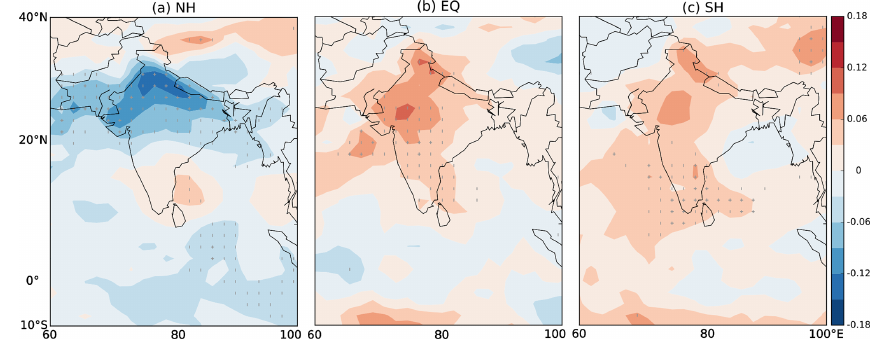
Figure 10. Spatial distribution of JJA mean total cloud cover (%) anomaly after the NH (a) , EQ (b) and SH (c) volcanic eruptions in 1992. The vertical bars and plus signs indicate the grid points with significant differences based on the two-tailed Student’s t tests at the 95% and 99% confidence level, respectively.